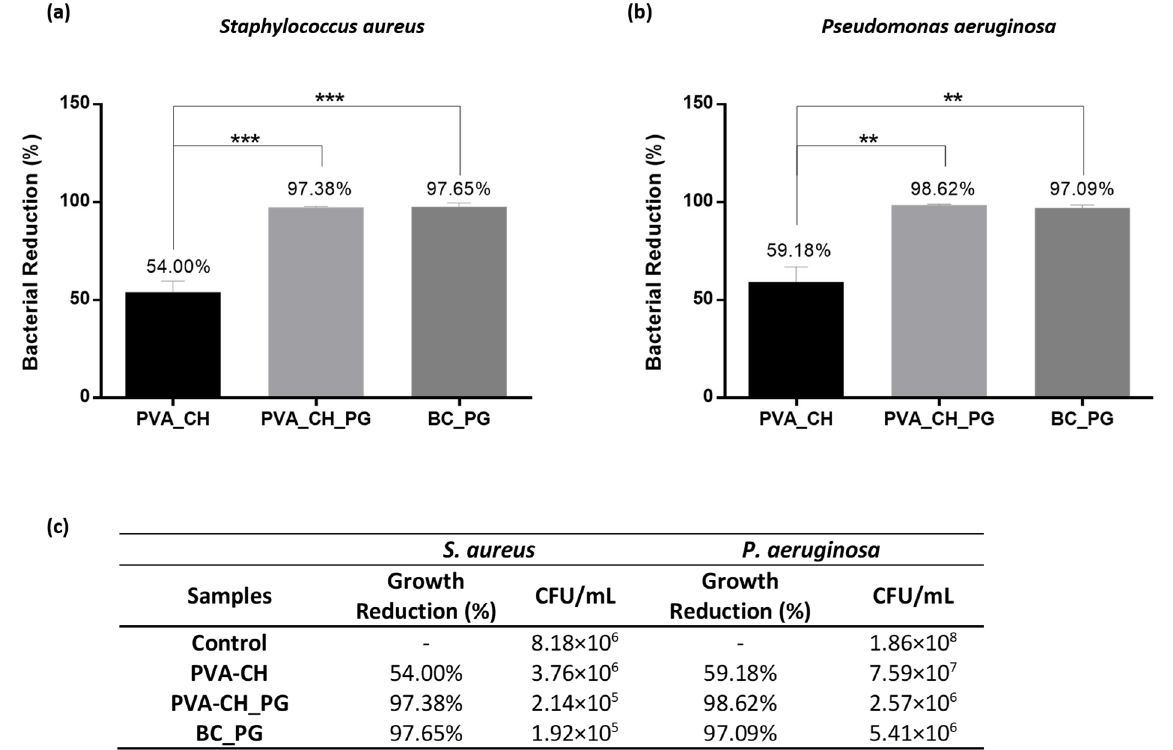
Figure 4. Evaluation of the antibacterial activity of PVA-CH coating layer, and both nanocomposite layers with PG pigment incorporated (PVA-CH_PG and BC_PG) against S. aureus ( a ) and P. aeruginosa ( b ). Correspondence between the percentage of bacterial reduction and the respective CFU/mL ( c ). (Values reported as mean ± SD, ** p < 0.01 and *** p < 0.001).